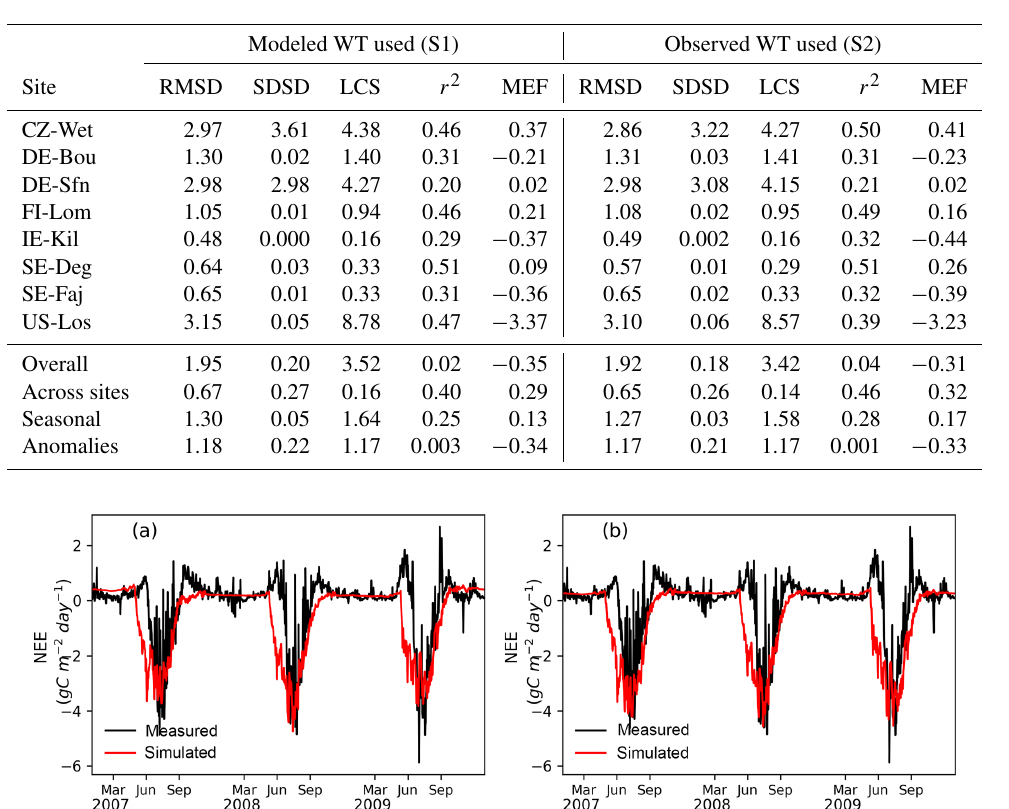
Table 6. Model performance measures of NEE simulations for the site-by-site comparison, comparison across sites, mean seasonal cycle, and anomalies, using modeled (S1) and observed (S2) WT.